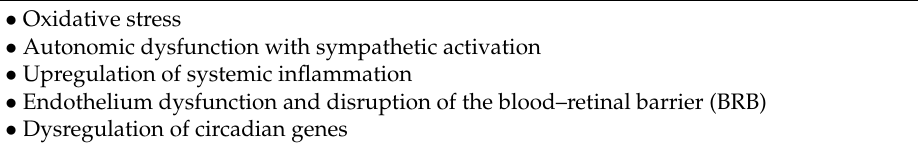
Table 1. Possible common pathophysiology between OSA and associated ocular complications.